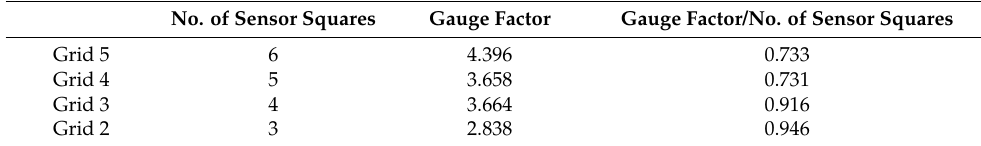
Table 1. The normalized gauge factors.